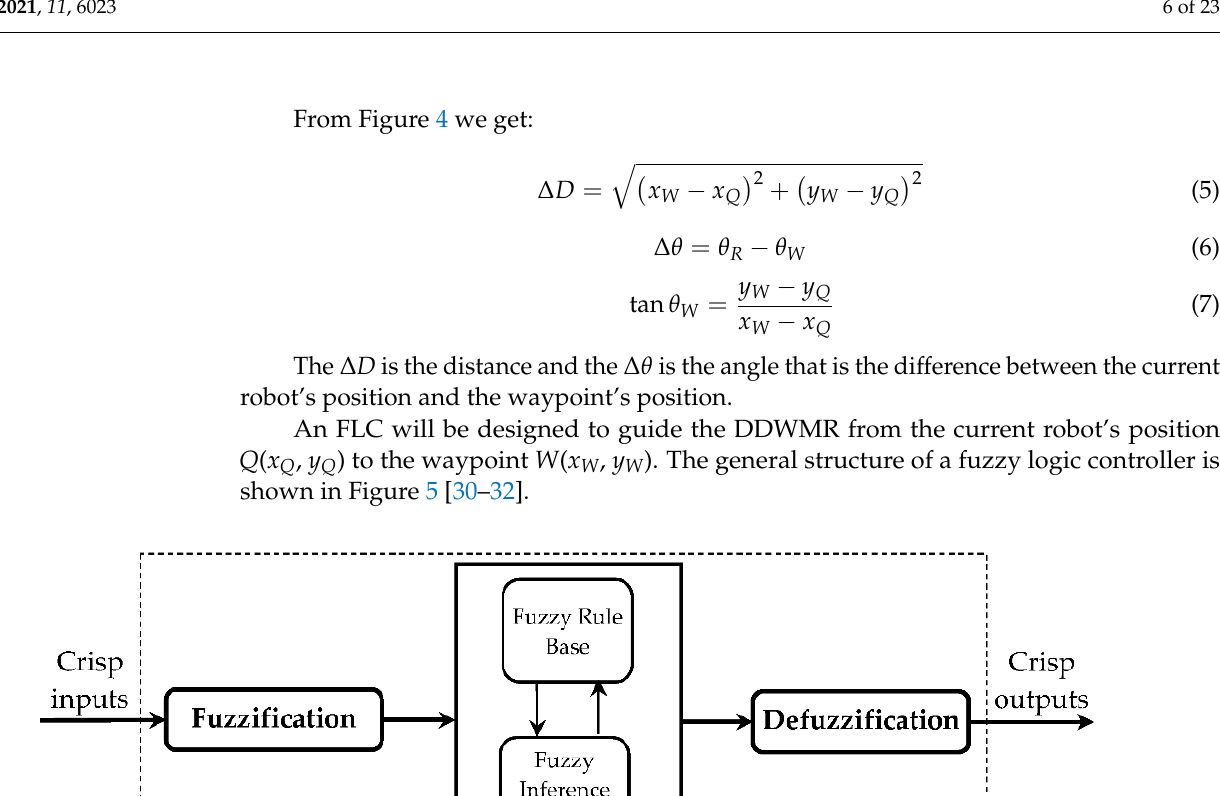
Figure 5. The fuzzy logic controller block diagram.